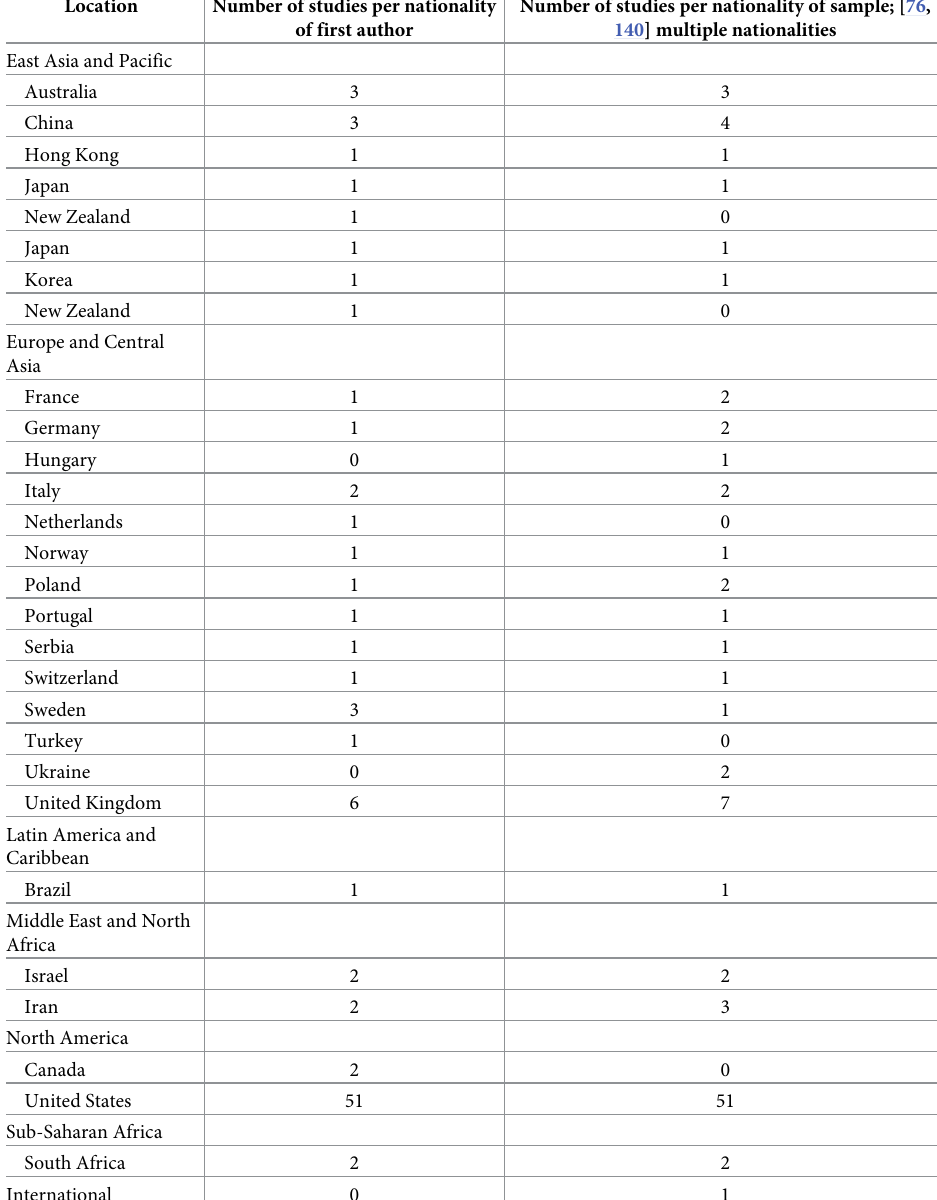
Table 3. Country of origin of grouped by geographic